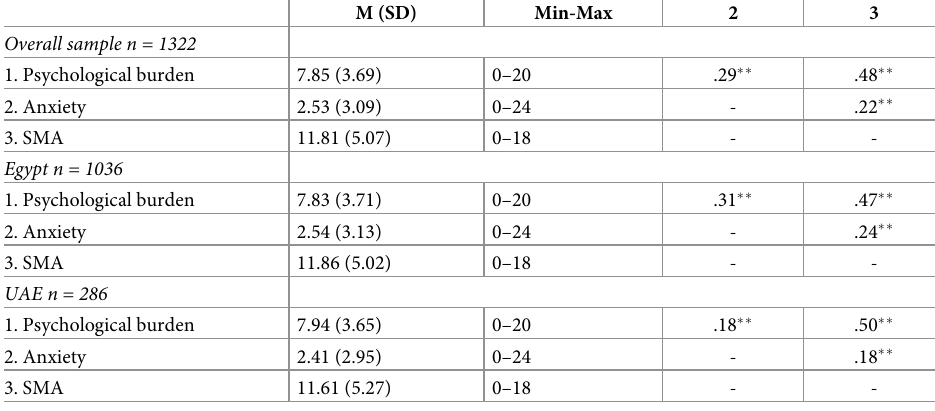
Table 2. Descriptive results and bivariate correlations between the study variables.